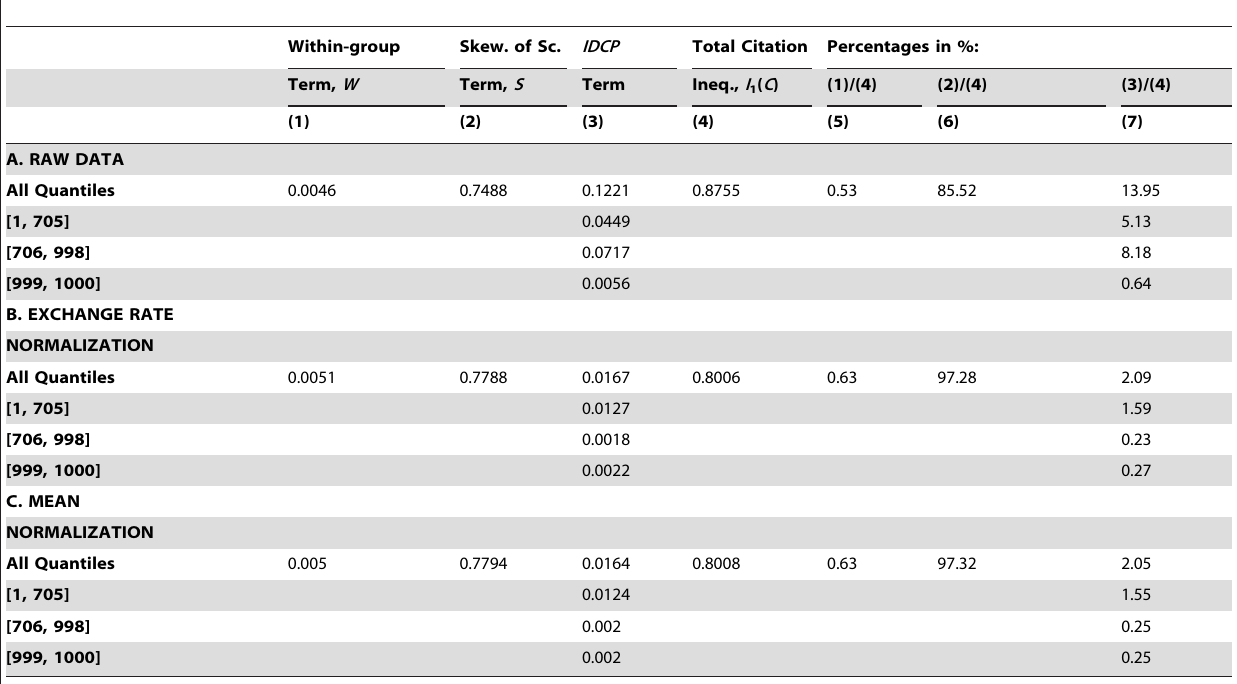
Table 2. Total Citation Inequality Decomposition Before and After Normalization: IDCP Interval Detail.